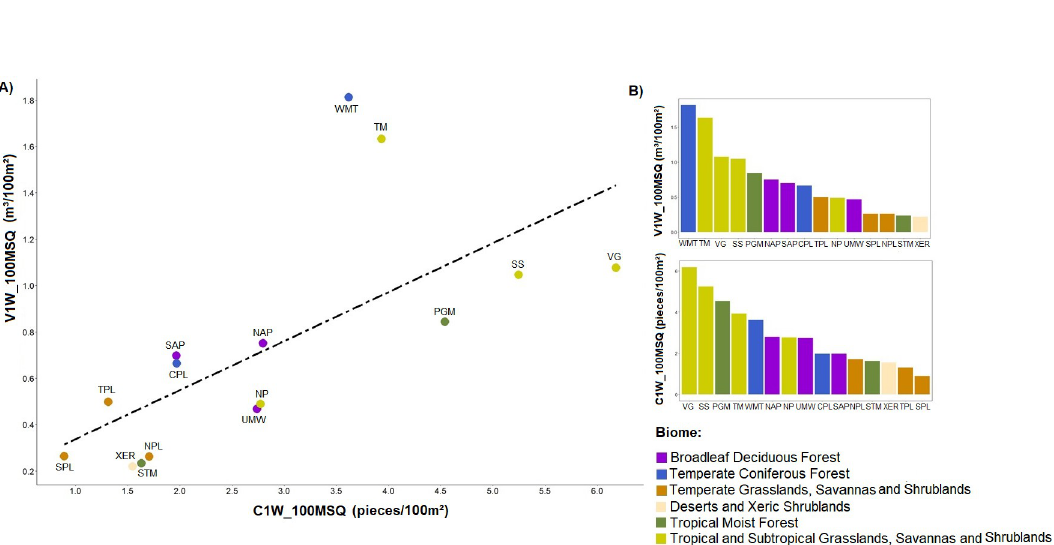
Fig 11. Charts of the mean quantities of instream wood for Brazil and USA regions. The large wood (LW) mean abundance (C1W_100MSQ) against LW mean volume per channel area (V1W_100MSQ) in (A) and the LW abundance and volume ranks per channel area in (B). The colours in the points and columns indicate the biome where each region is located.